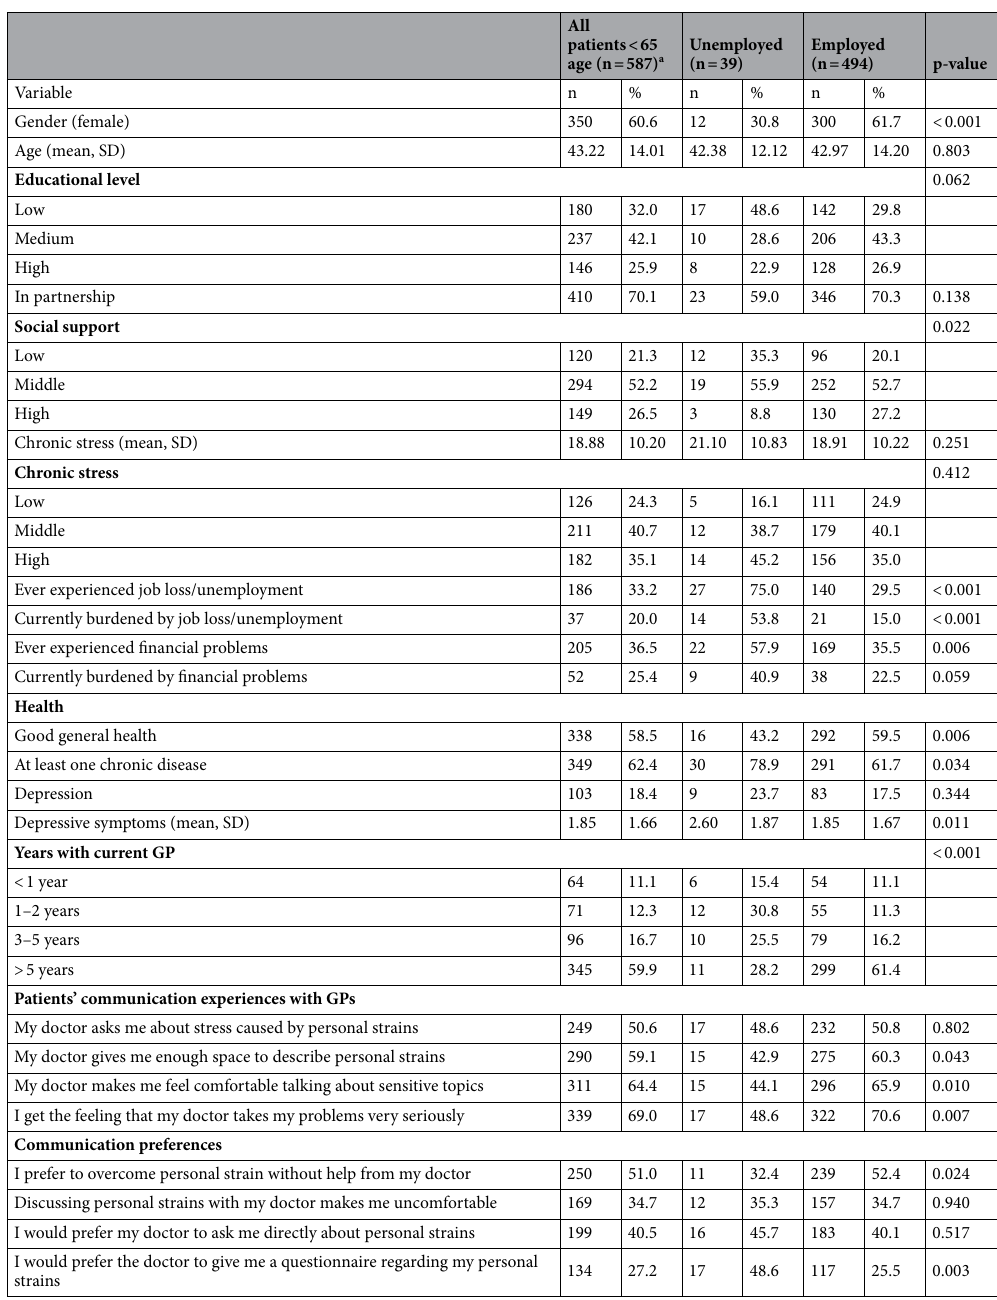
Table 3. GPCare-1: Characteristics of working-age patient population, stratified by employment status (n = 587). a Statistical tests are based on n = 533 total participants, as n = 54 did not report their employment